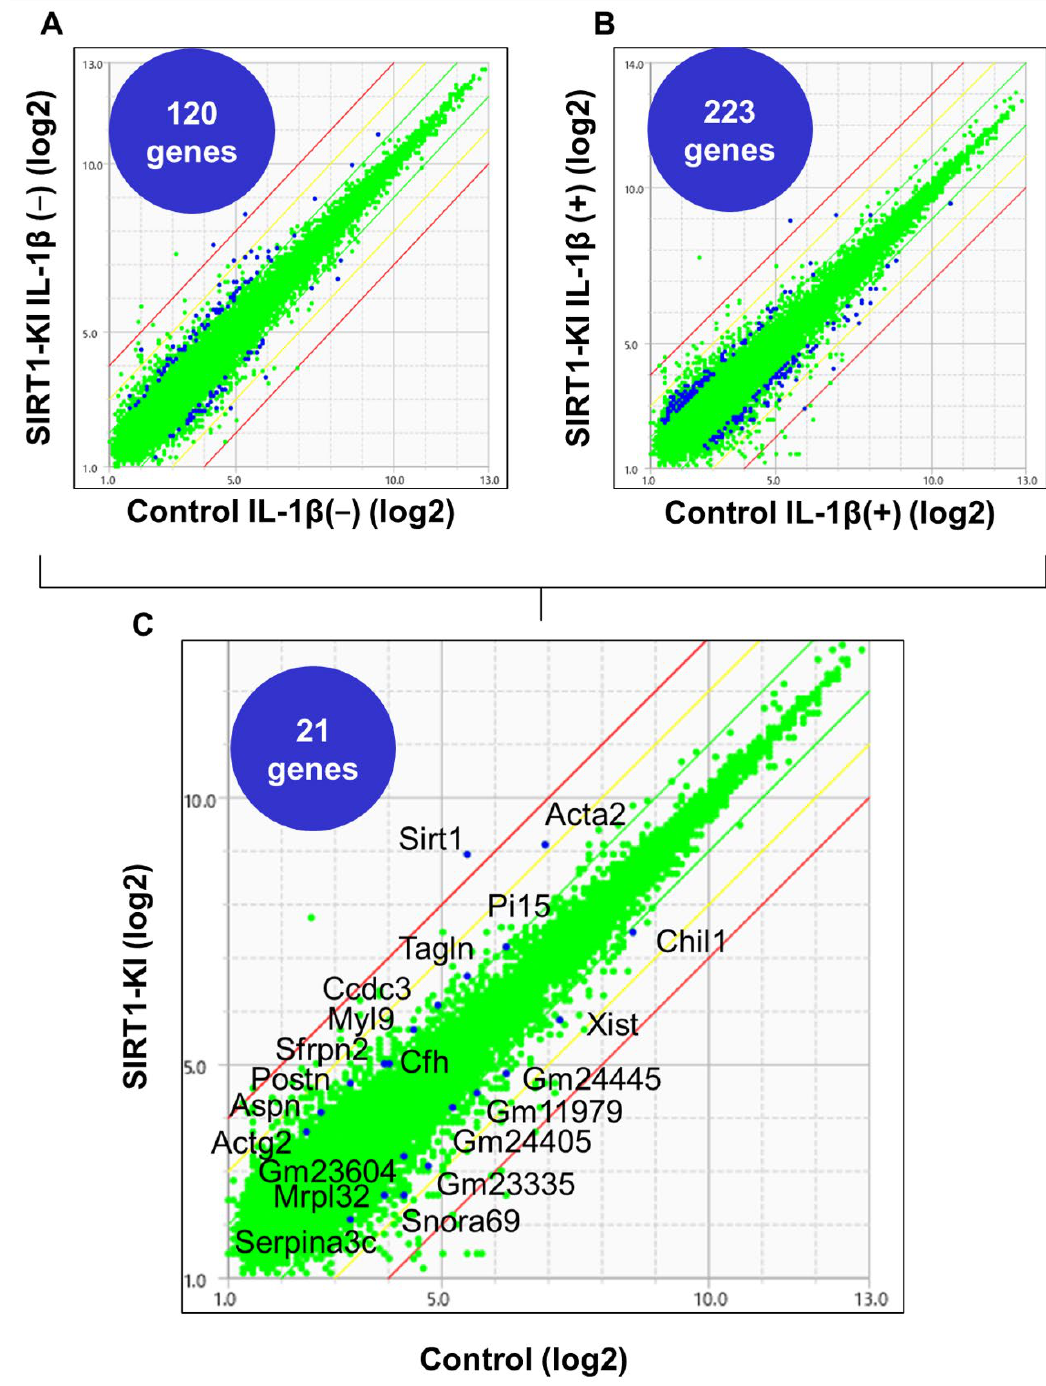
Figure 6. Scatter plots showing the correlation of signal values between two samples from chondrocytes without IL-1 β stimulation and chondrocytes with IL-1 β stimulation. ( A ) Upon gene expression profiling on SIRT1-KI chondrocytes, 120 genes were found to be upregulated or downregulated, with a two-fold change cut-off in chondrocytes without IL-1 β stimulation. ( B ) Upon gene expression profiling on SIRT1-KI chondrocytes, 223 genes were found to be upregulated or downregulated, with a two-fold change cut-off in chondrocytes with IL-1 β stimulation. ( C ) There were 21 genes involved in both of the above.